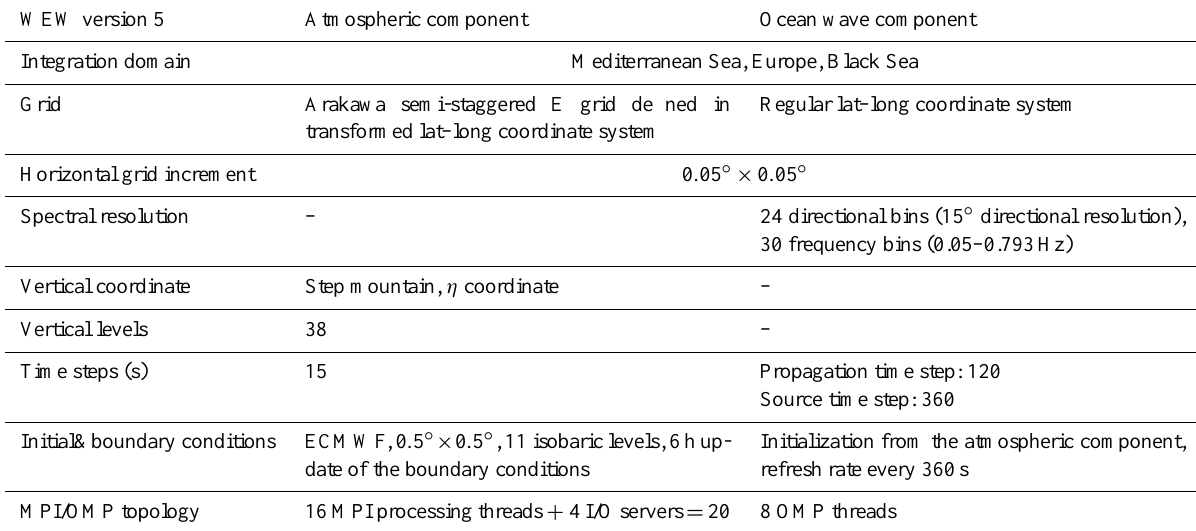
Table 1. The configuration of the WEW.